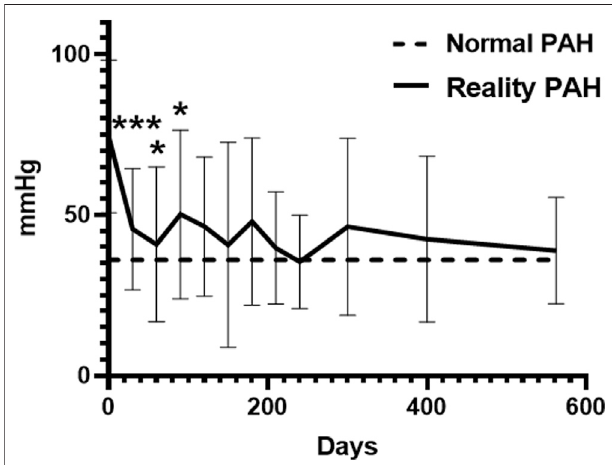
FIGURE 2 | PAH changes in 2 years including preoperation, postoperation, and follow up.* p < 0.05; ** p < 0.01; *** p < 0.001.